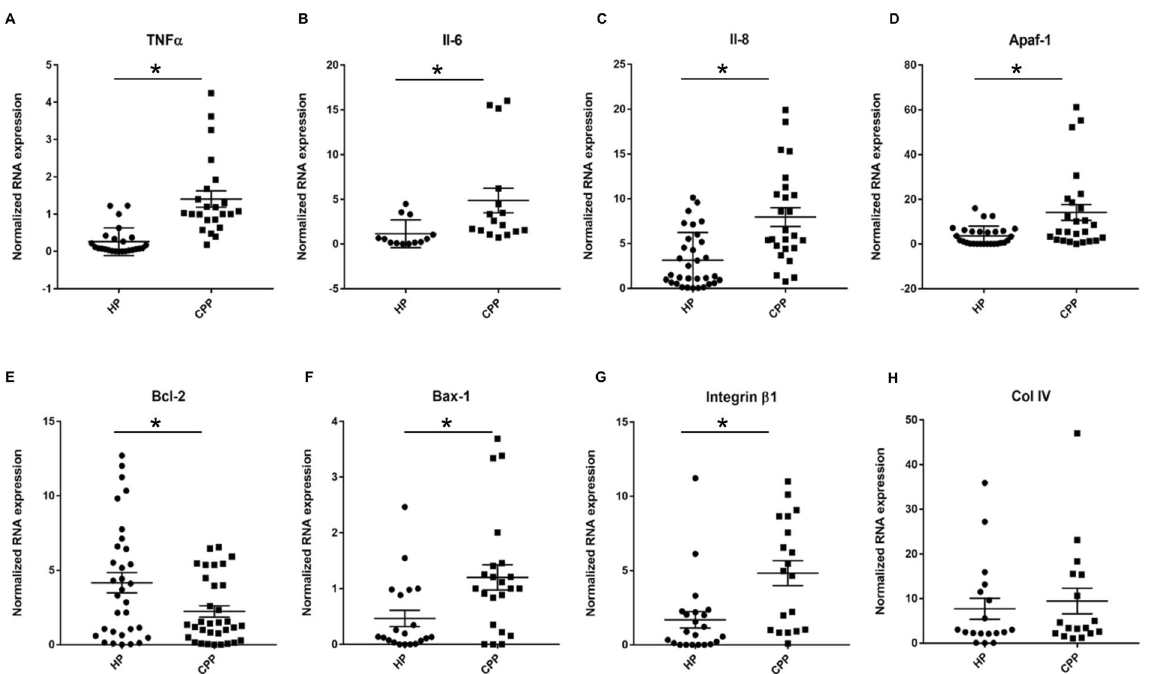
Figure 8. Inflammatory and pro-apoptotic cell death related gene expression is increased in chronic periodontitis samples. ( A – F ) Gene expression of inflammatory and pro-apoptotic cell death response related genes: TNF- α , IL-6, IL-8, Apaf-1, Bcl-2 and Bax-1 from mRNA extracted from chronic periodontitis patients (CPP) (11 patients) and healthy patients (HP) (9 patients); ( G , H ) Gene expression of integrin β 1 and collagen IV from mRNA extracted from chronic periodontitis patients (CPP) (11 patients) and healthy patients (HP) (9 patients). * Differences between CPP and HP samples ( p <